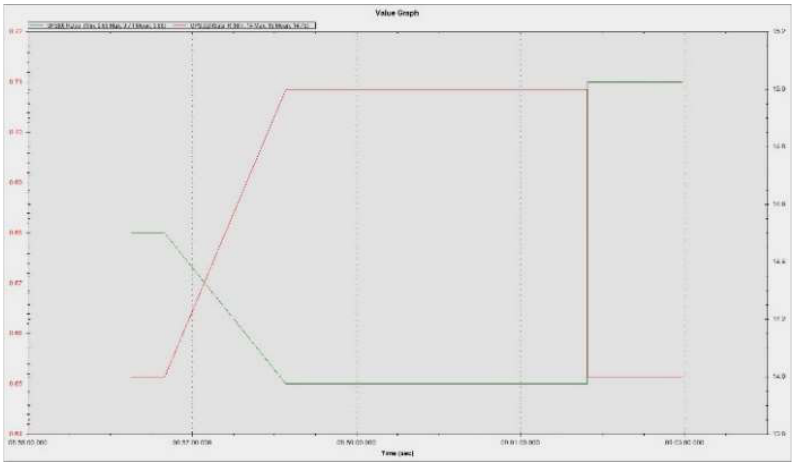
Figure 32. Accuracy of HDop positioning data received from GPS satellites.